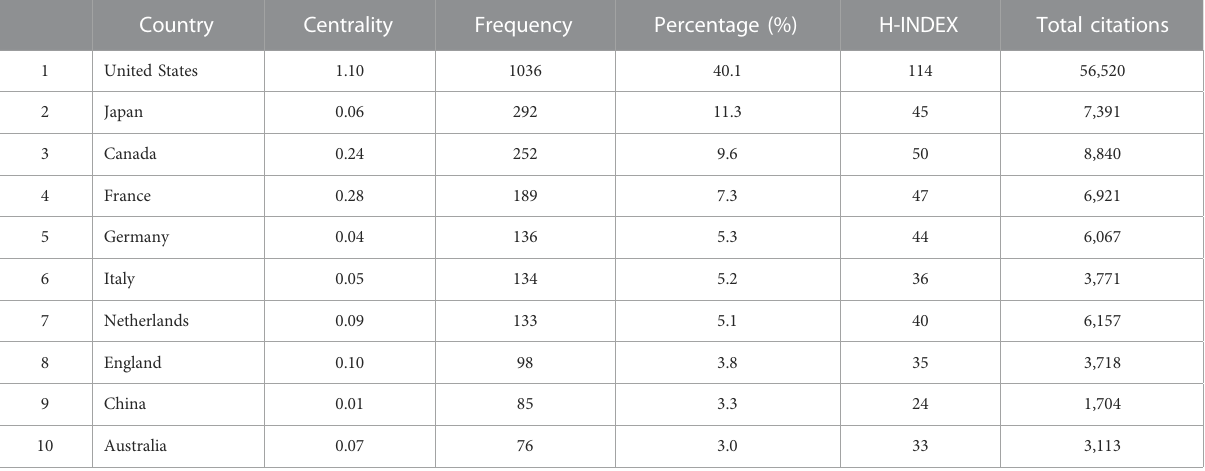
TABLE 2 The Top 10 countries that published studies on